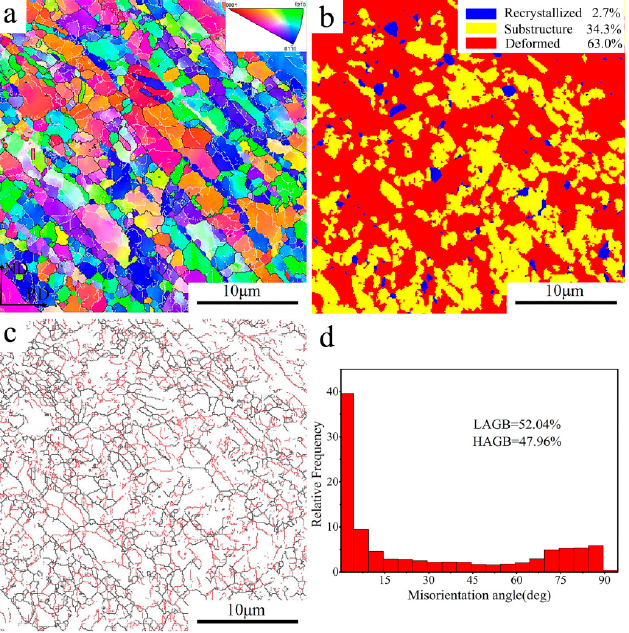
Figure 2. Microstructure characteristics of the UFG TiFeB alloy: ( a ) inverse pole figures (IPF) map; ( b ) recrystallization map; ( c , d ) maps of grain boundaries and the misorientation angle distributions.